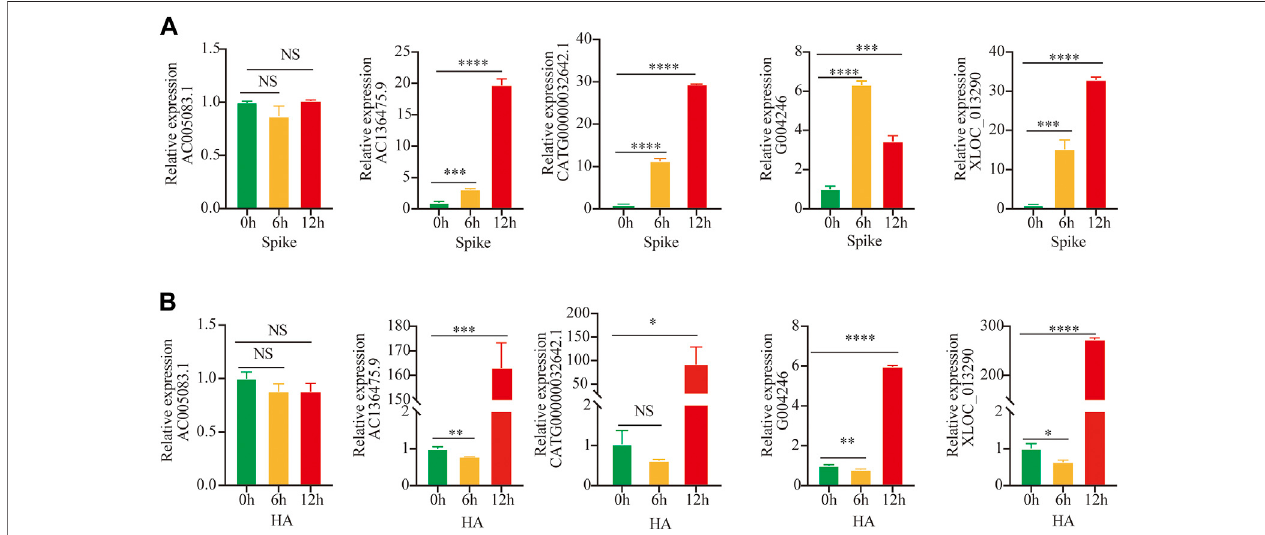
FIGURE2| ValidationbyQuantitativeRT-PCR. (A,B) ExpressionsoflncRNAsweredetectedafterstimulationbyS-protein andHAfor0,6,and 12 hinHuT78cell co-cultured with the activated THP-1; statistical comparisons are indicated by the arrows; p p < 0.05, ** p < 0.01, *** p < 0.001, **** p < 0.0001; comparisons were done using the ANOVA test.